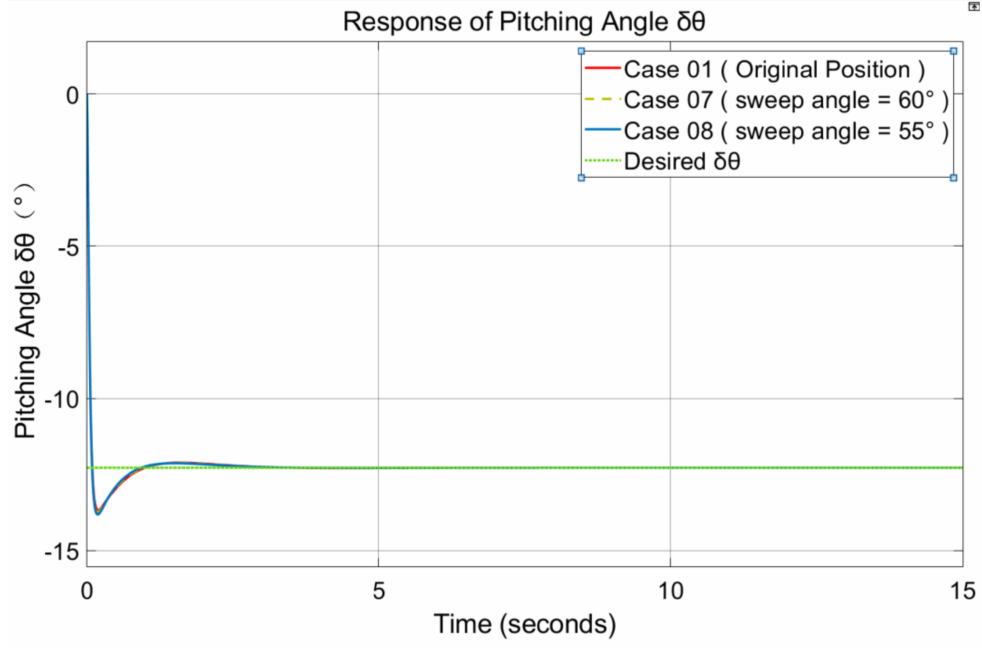
Figure 24. Response of the pitching Angle ( δθ ) with controller (cases 01, 07 and